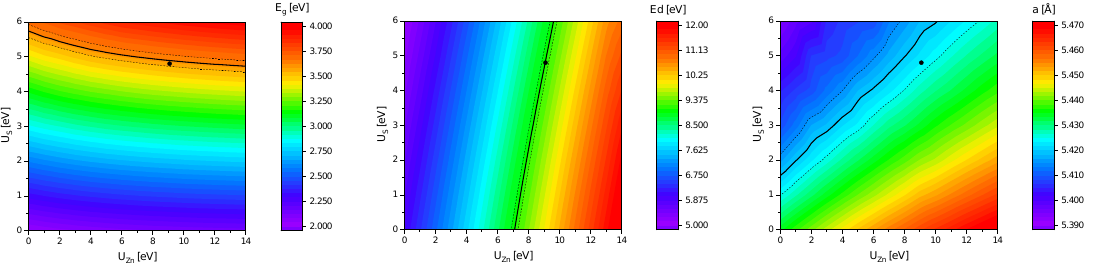
Figure 4. Trend of the band gap E g ( left ), the difference of the valence band maximum and the Zn 3d states Ed ( middle ) and the lattice parameter a ( right ) with respect to the U Zn and U S parameter. Table 1. Comparison of generalized gradient approximation (GGA), GGA+U and experimental results for ZnS.